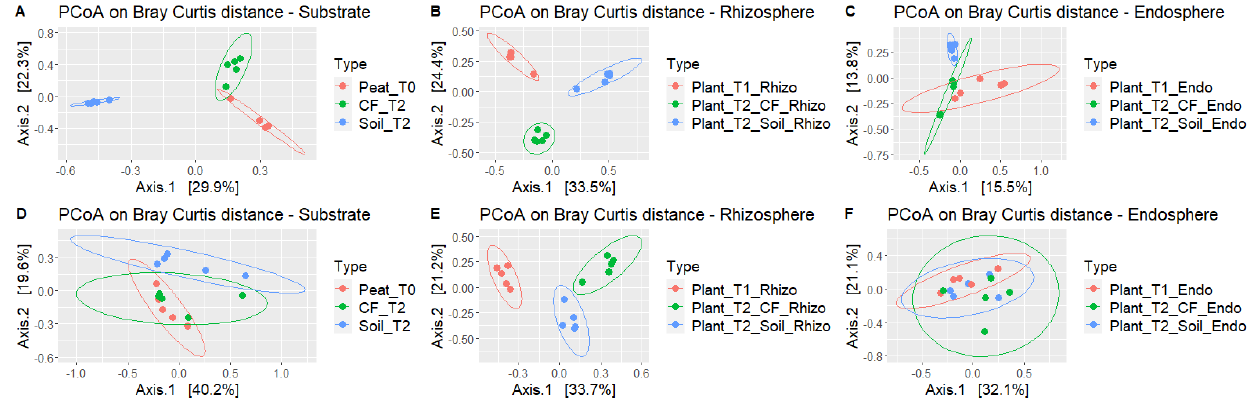
Figure 5. PCoA of bacterial ( A – C ); and fungal communities ( D – F ) based on amplicon sequencing data. Sample clustering was based on the Bray – Curtis dissimilarity matrix. Each point on the graph corresponds to a single sample (biological replication).